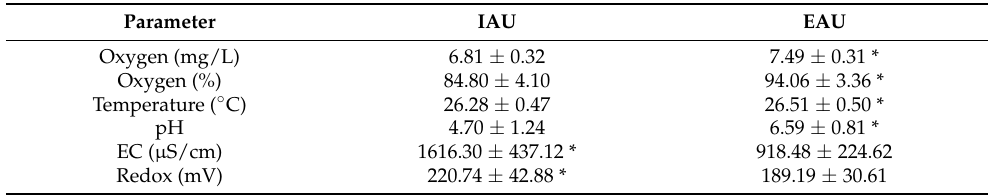
The “*” sign within a row indicates statistically higher mean values at p <